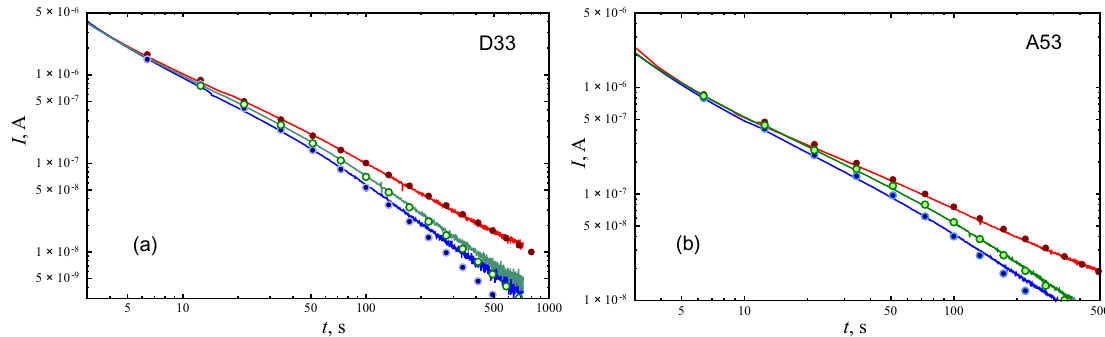
Figure 5. Comparison of measured charging and discharging ( θ = 100 and 200 s) curves (lines) for PMSC D33 ( a ) and A53 ( b ) with linear responses predicted by the equivalent circuit model with parameters indicated in Table 1 (points).